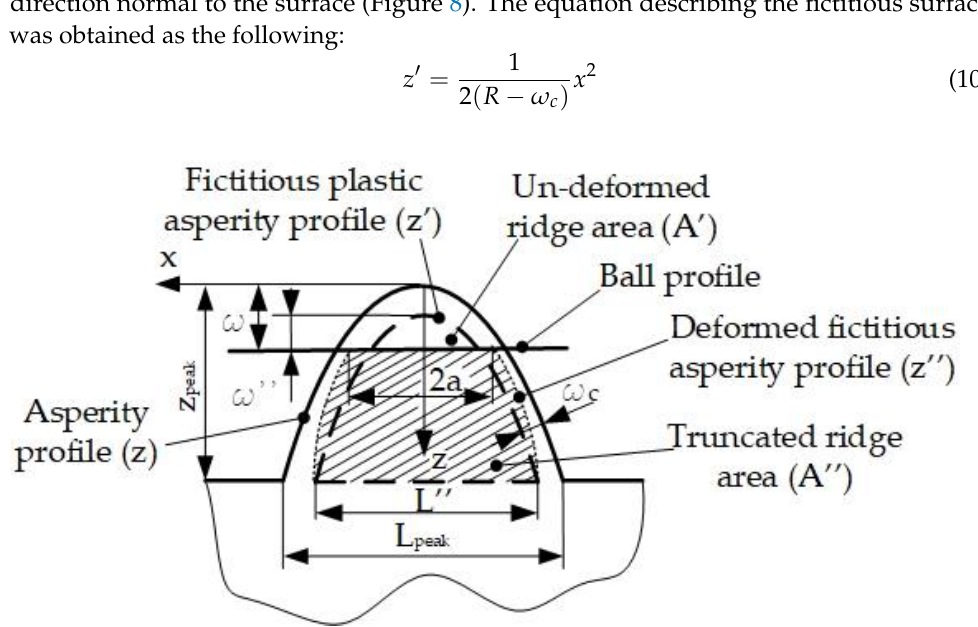
Figure 8. Plastic interaction between ball profile and parabolic